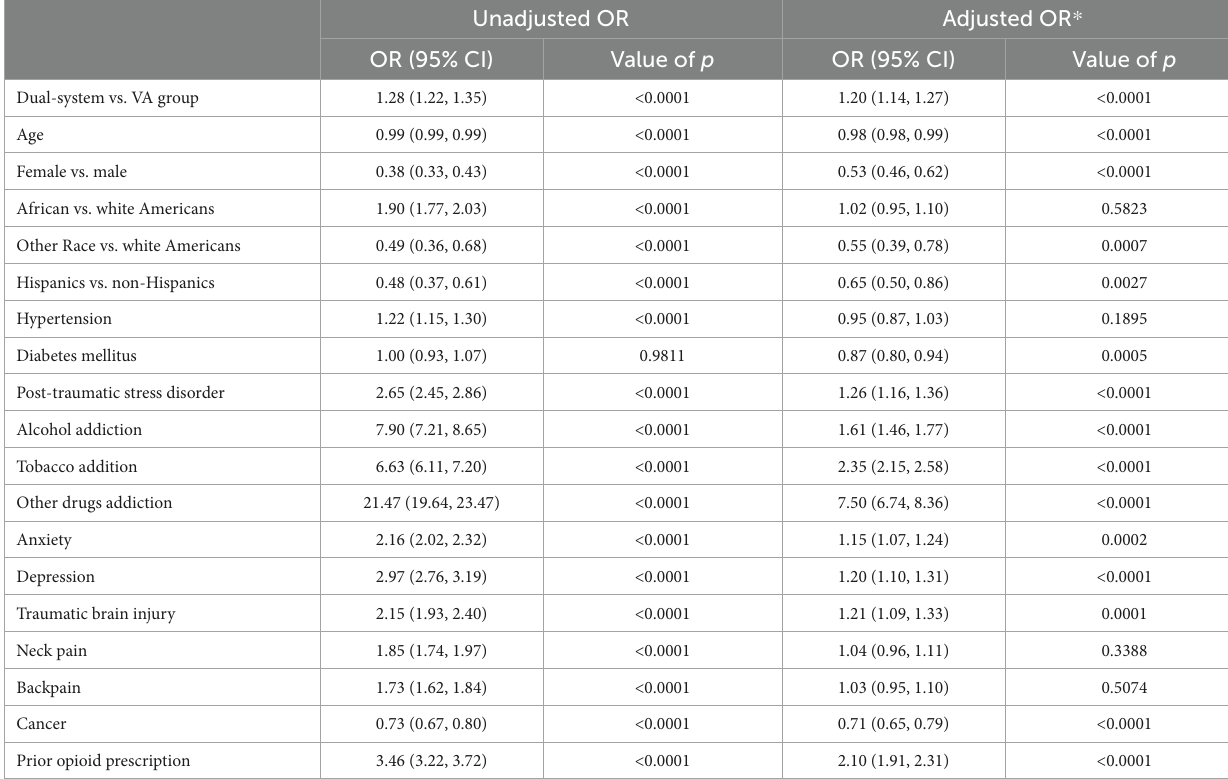
TABLE 6 OUD in mono vs. dual-system users in DC and Baltimore VA from 2015 to